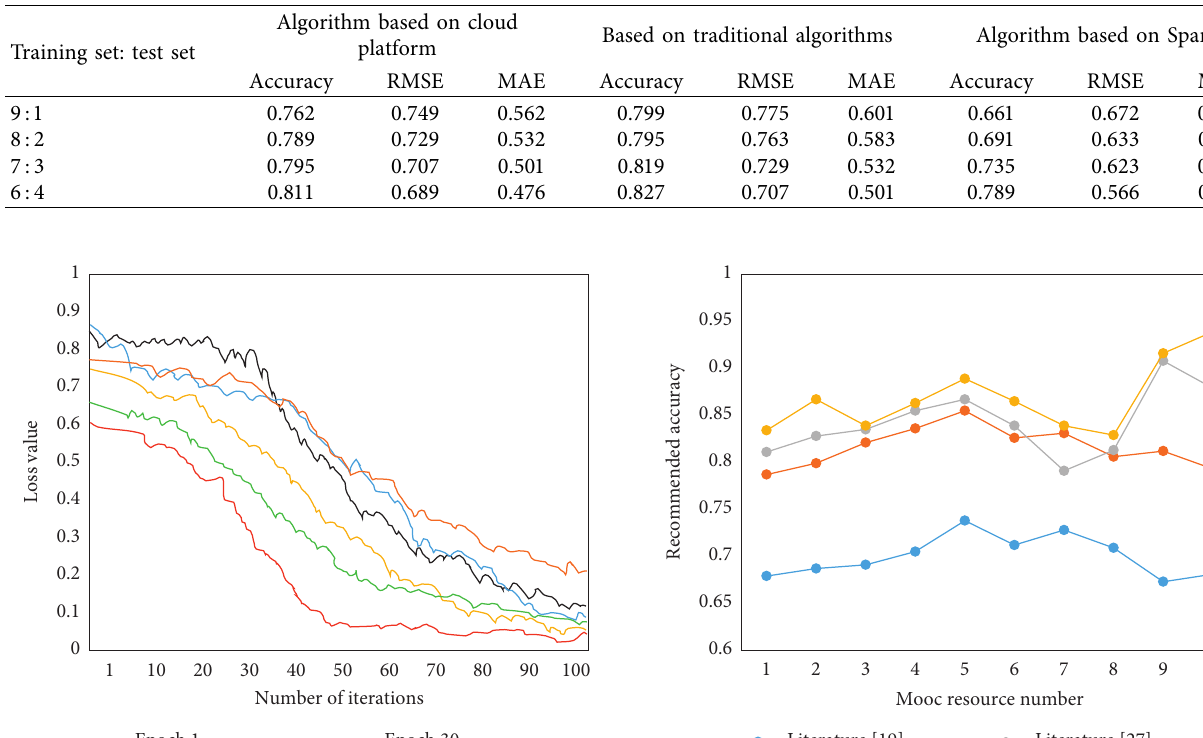
Figure 7: Loss gain and accuracy under different negative sampling ratios. (a) Normalized loss cumulative gain under different negative sampling ratios. (b) Accuracy under different negative sampling ratios. Table 2: MAE, RMSE, and accuracy of different proportions of the training set and test set.